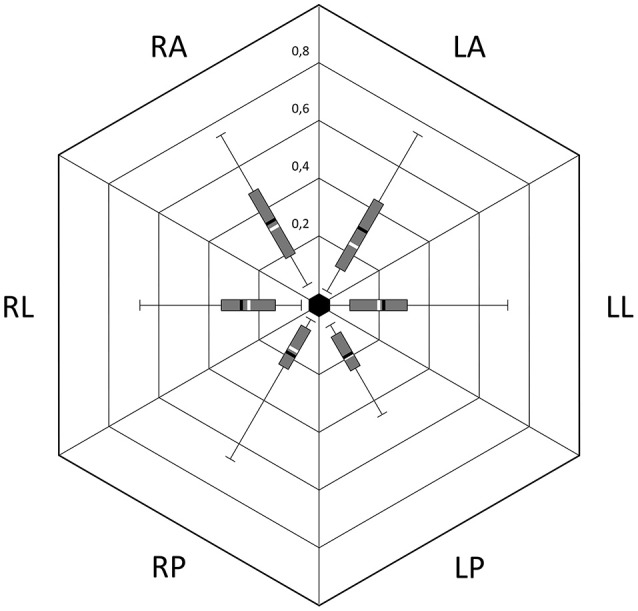
Distribution of VOR gains during vHIT; Box, 1st and 3rd quartile; T-Bars, edge values; Black bar, mean; White bar, median; RA, Right anterior; LA, Left anterior; LL, Left lateral; LP, Left posterior; RP, Right posterior; RL, Right lateral.